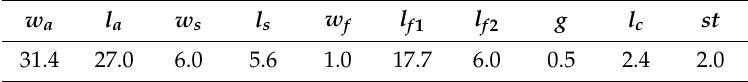
Figure 13. Simulated and measured reflection coefficient of the antenna in the free space and on human body. ( a ) D-fed Rect-MSA; ( b ) P-fed I-shape MSA. Table 2. Dimension of the proposed P-fed I-shape MSA of Figure 6 (units in